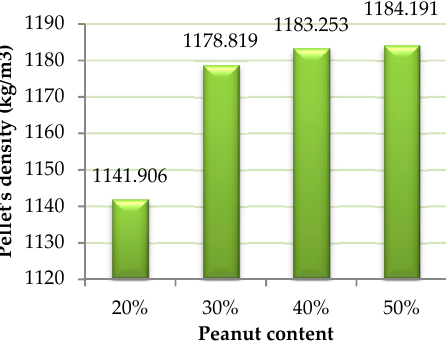
Figure 2. Effect of peanut content in the mixture with sponge flour on the density of